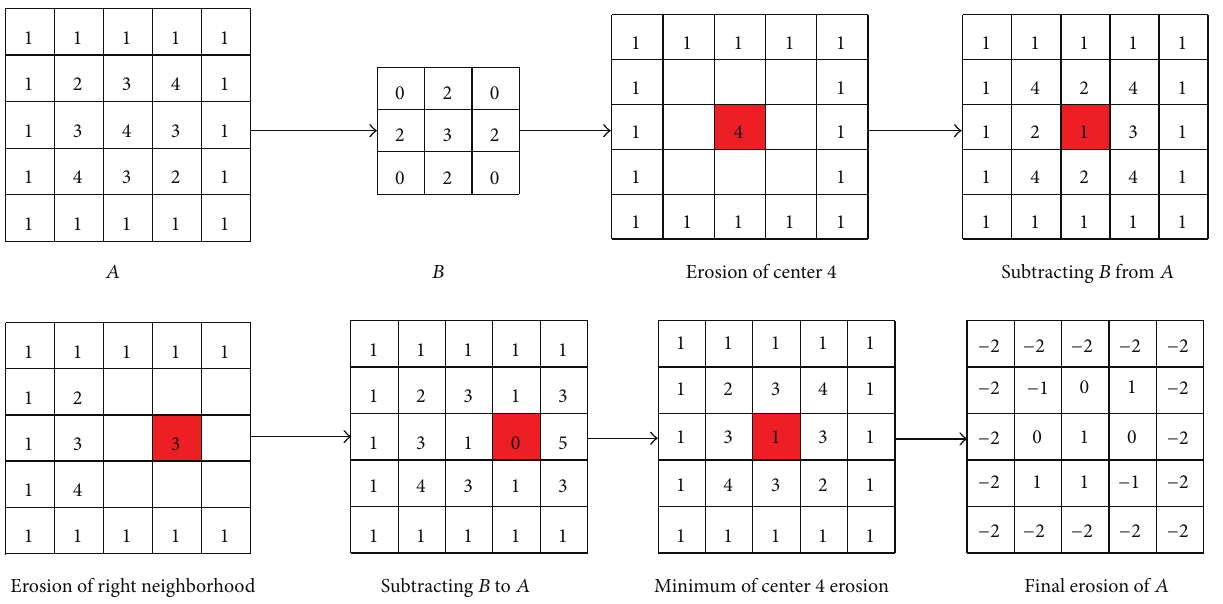
Figure 4: Example of an erosion (the red box represents the erosion of center 𝐴 ).